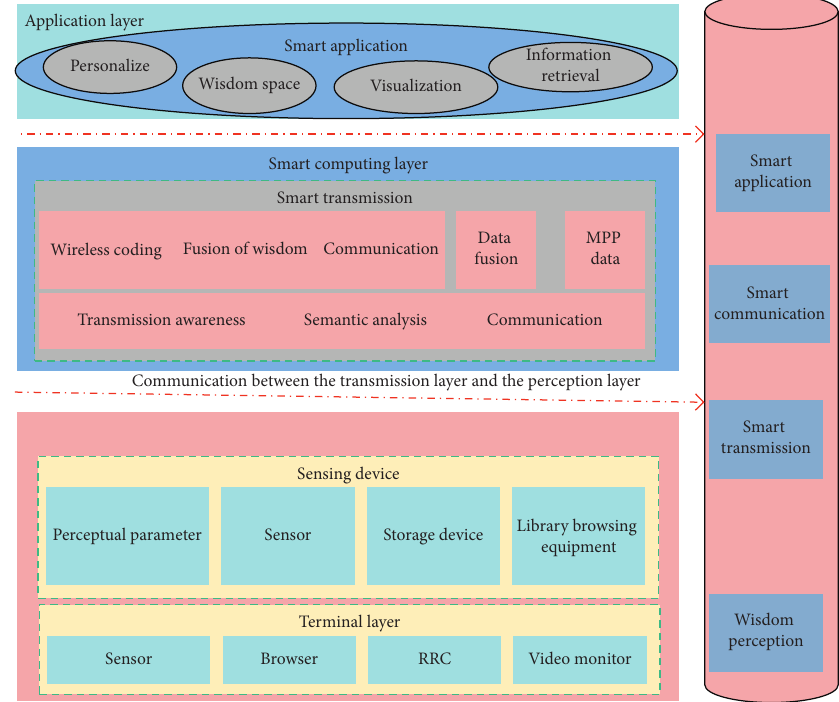
Figure 1: Architecture of the intelligent library information retrieval technology model construction